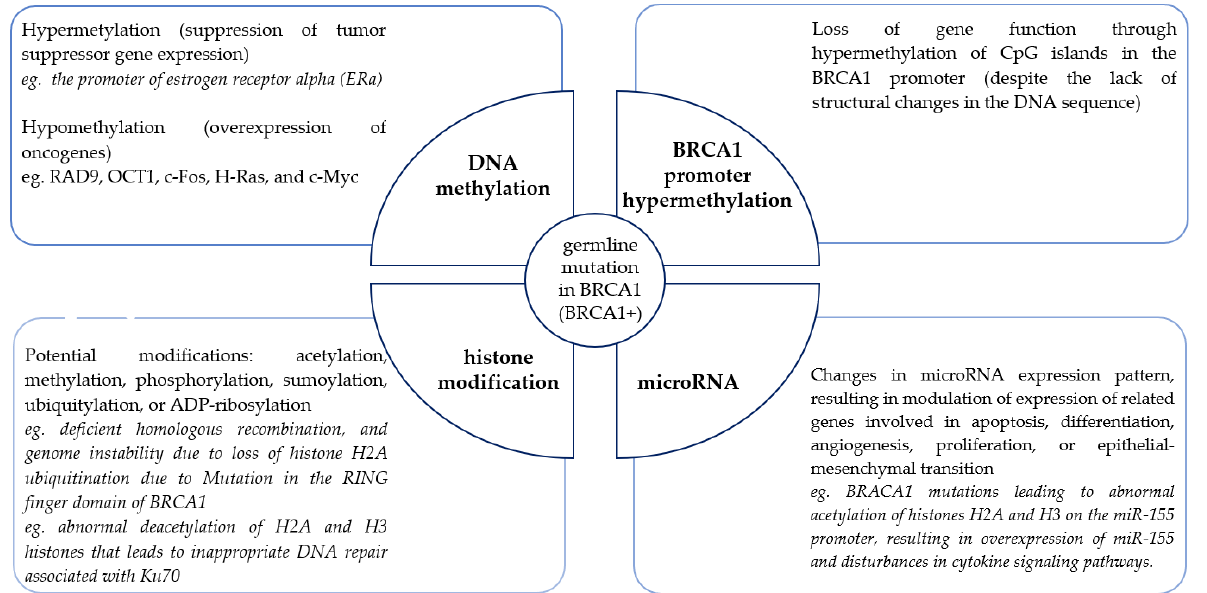
Figure 1. Landscape of epigenetic changes in familial breast cancer associated with the BRCA1 gene (based on [56] ).